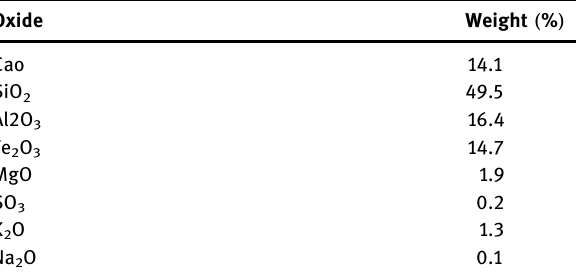
Table 5: The chemical composition of VP